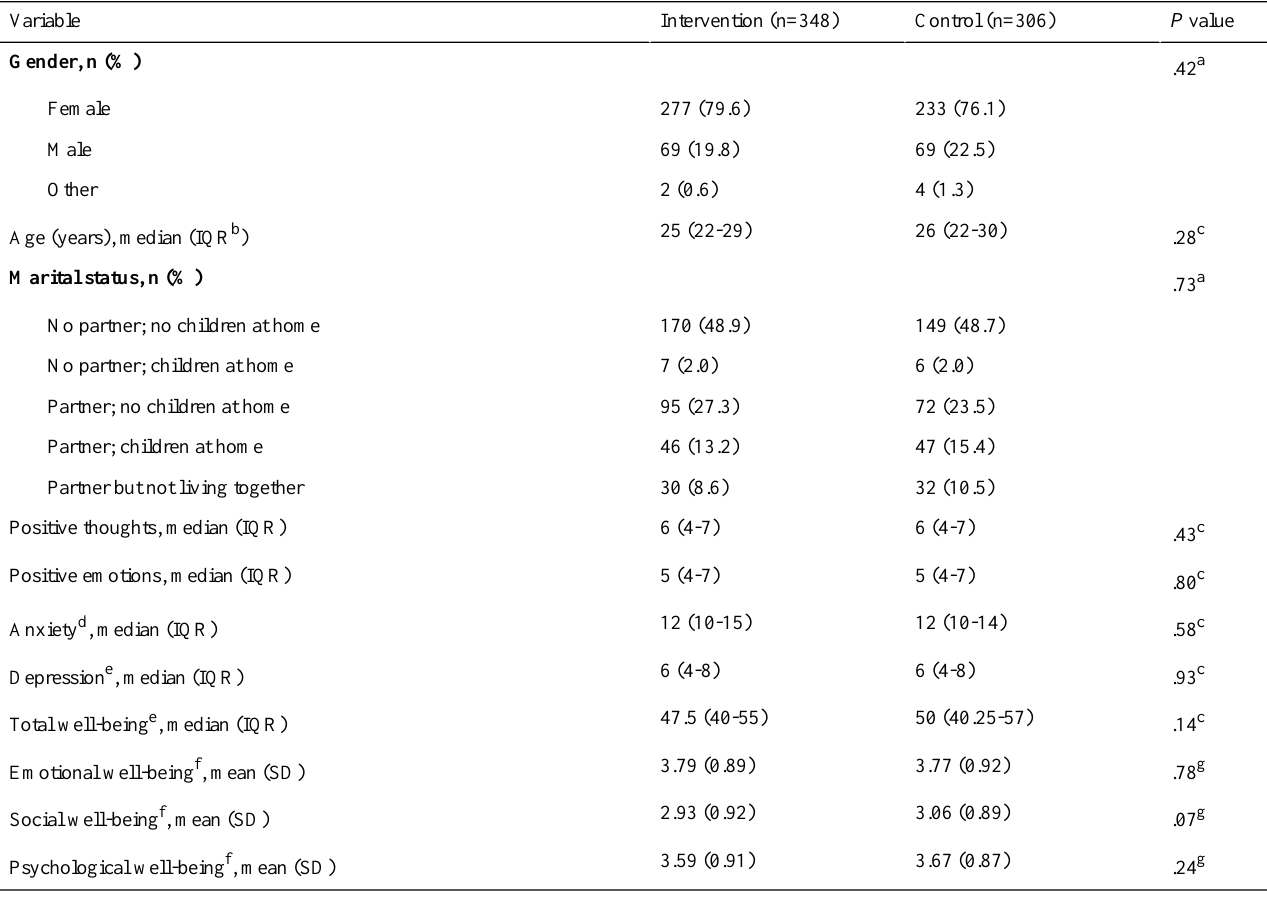
Table 2. Baseline characteristics for both study